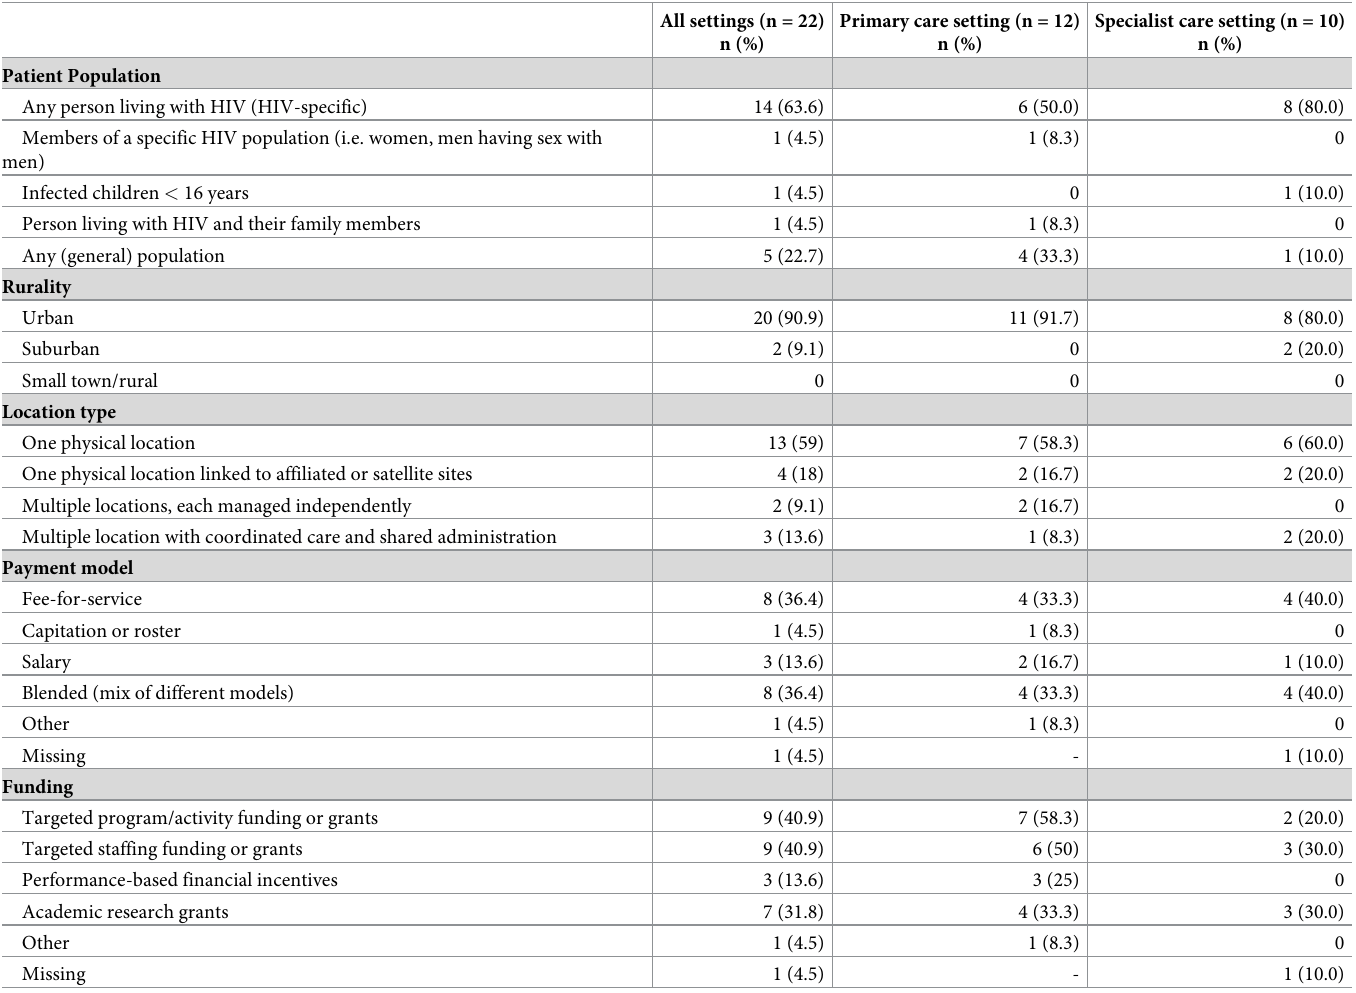
Table 2. Patient population, location, payment model, and funding of participating HIV care